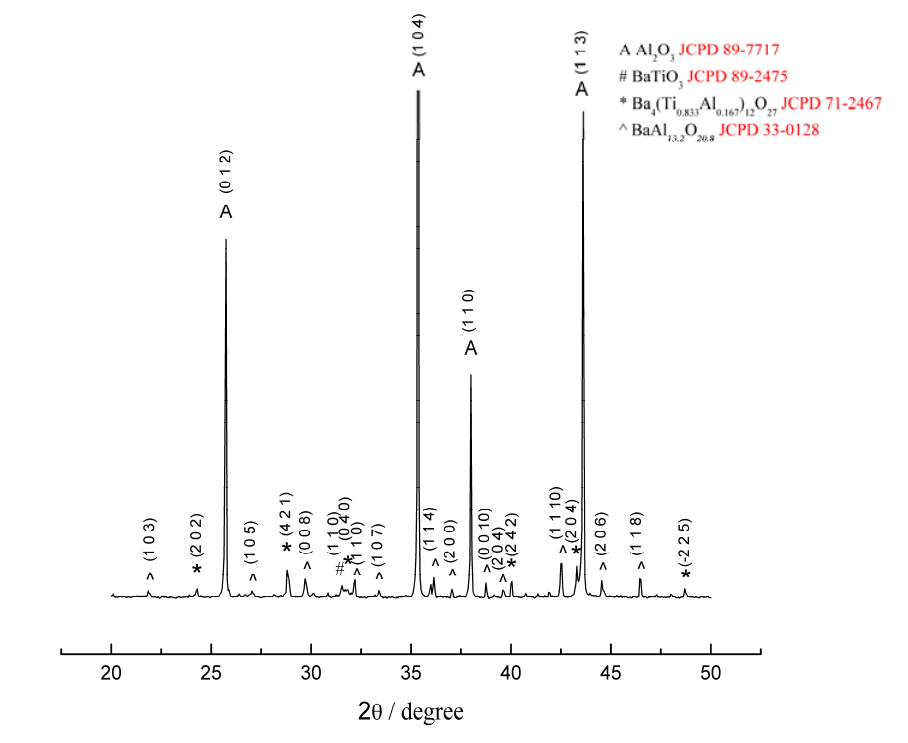
-platelet composite after hot-pressing at 1,400 ° 3